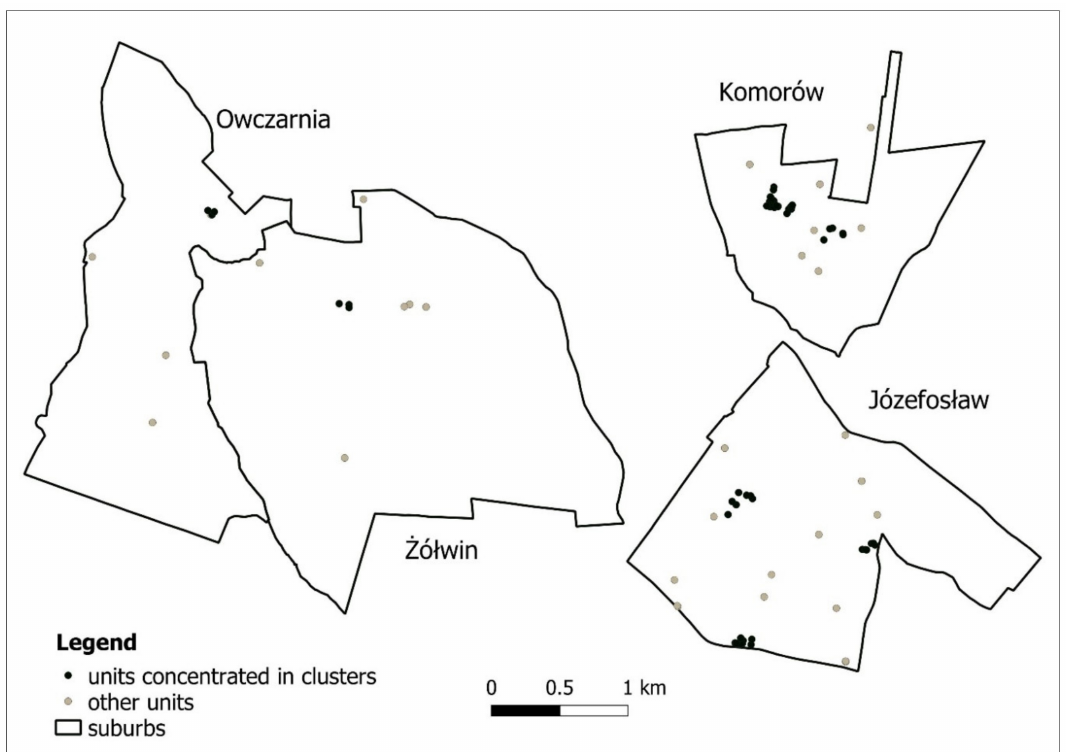
Figure 3. Units of other than residential function concentrated in